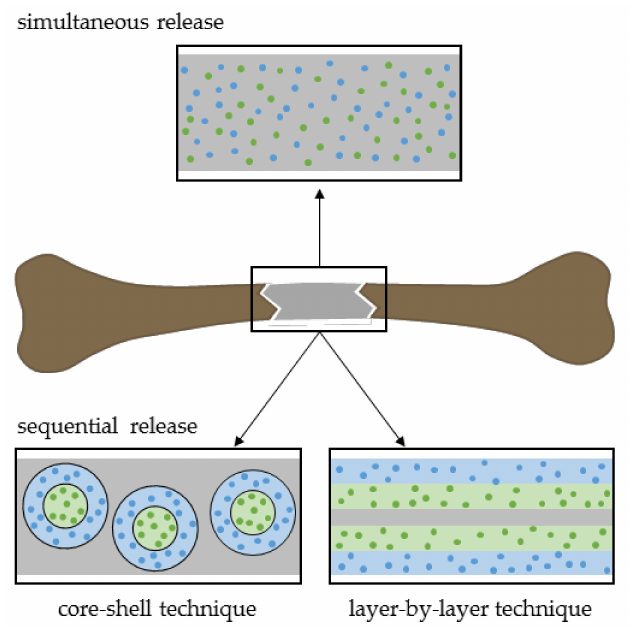
Figure 7. Exemplary drug loading techniques for simultaneous or sequential drug